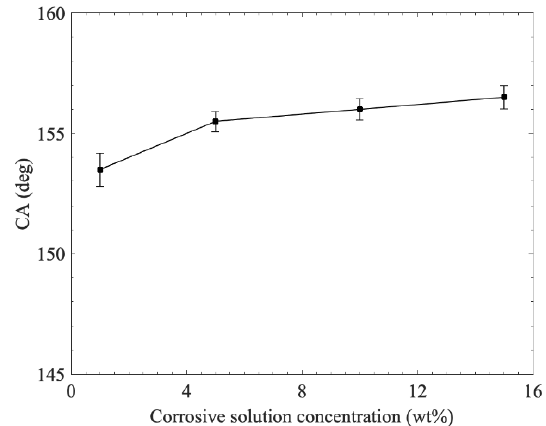
Figure 9. Effect of the corrosive solution concentration on the wettability of the copper surface.